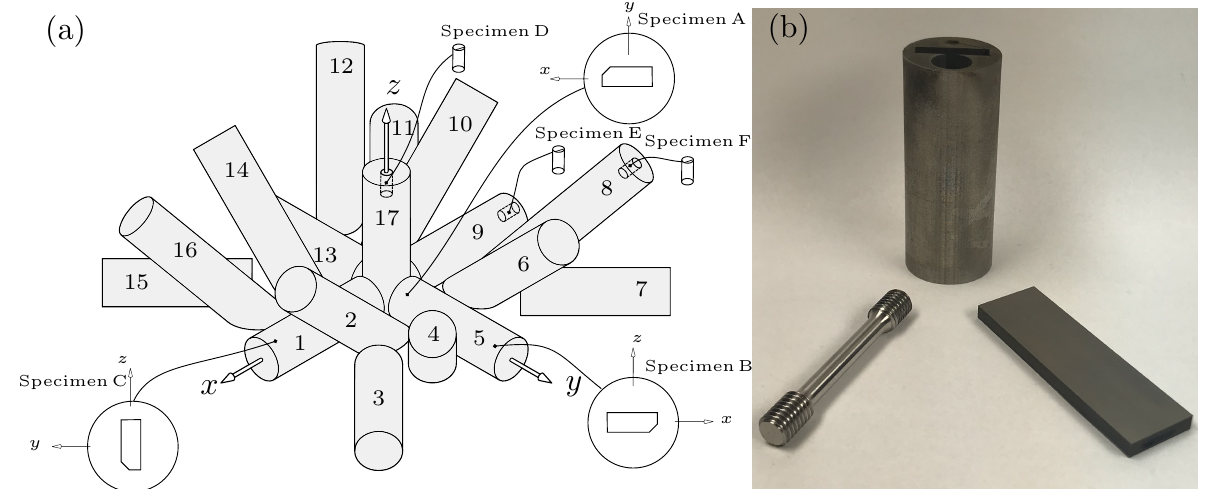
Figure 1. ( a ) Batch of cylindrical specimens showing the locations of specimens for analysis by EBSD (specimen A–C) and by HE-XRD (specimen D–F). ( b ) Machined specimens for tensile loading experiments and